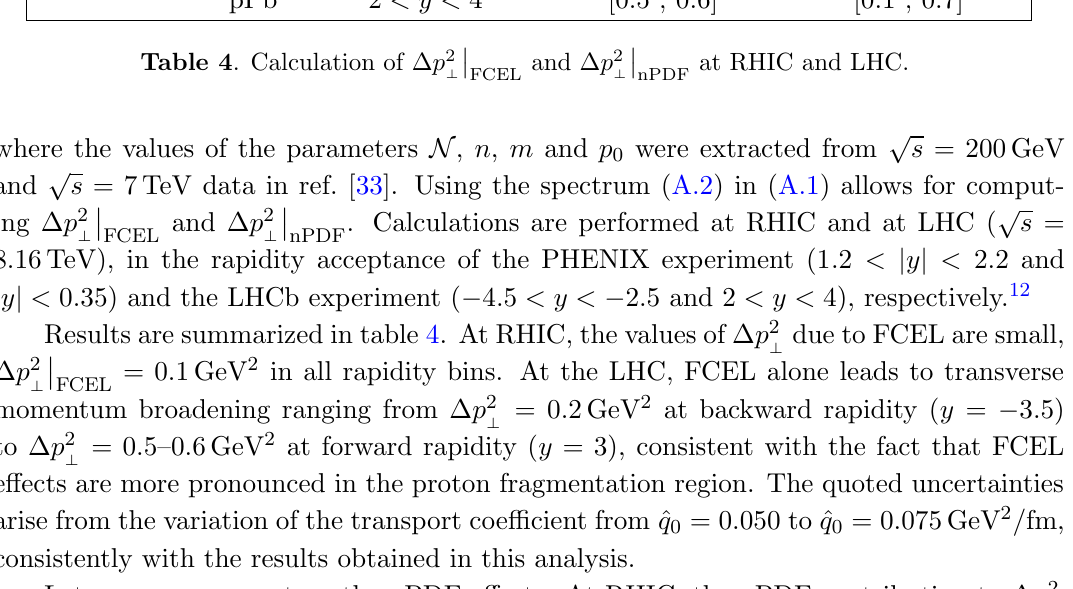
Table 4 . Calculation of (cid:1) p 2